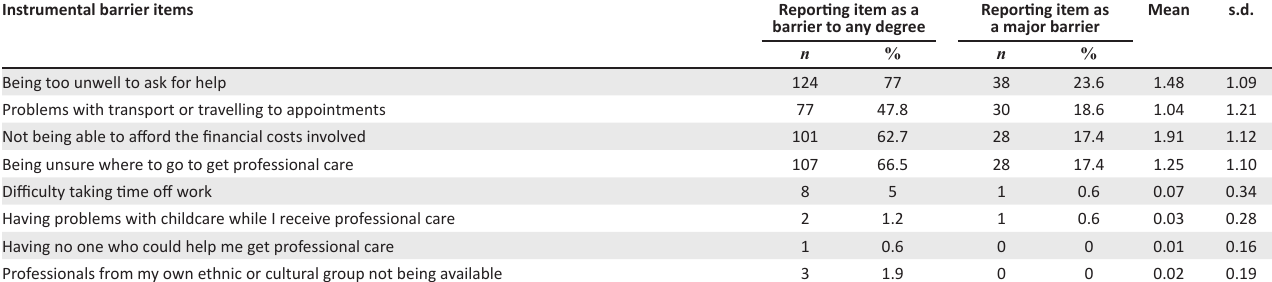
TABLE 5: Instrumental